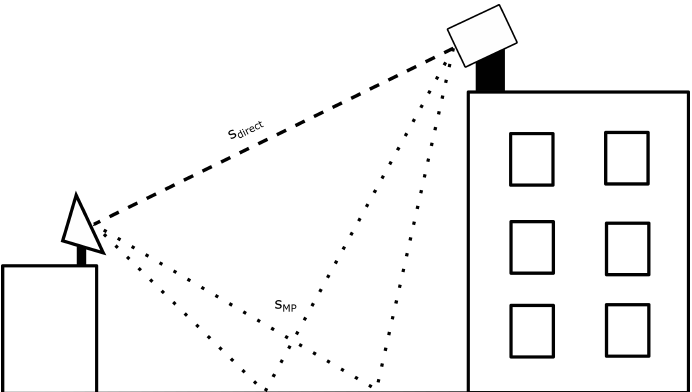
Figure 7. Multi-path model used for data